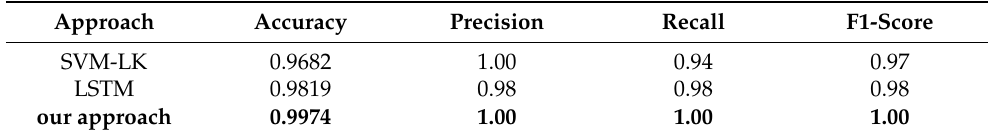
Table 1. Performance comparison of our approach with the method proposed in [27]. Figures in bold refer to the best performing approach.